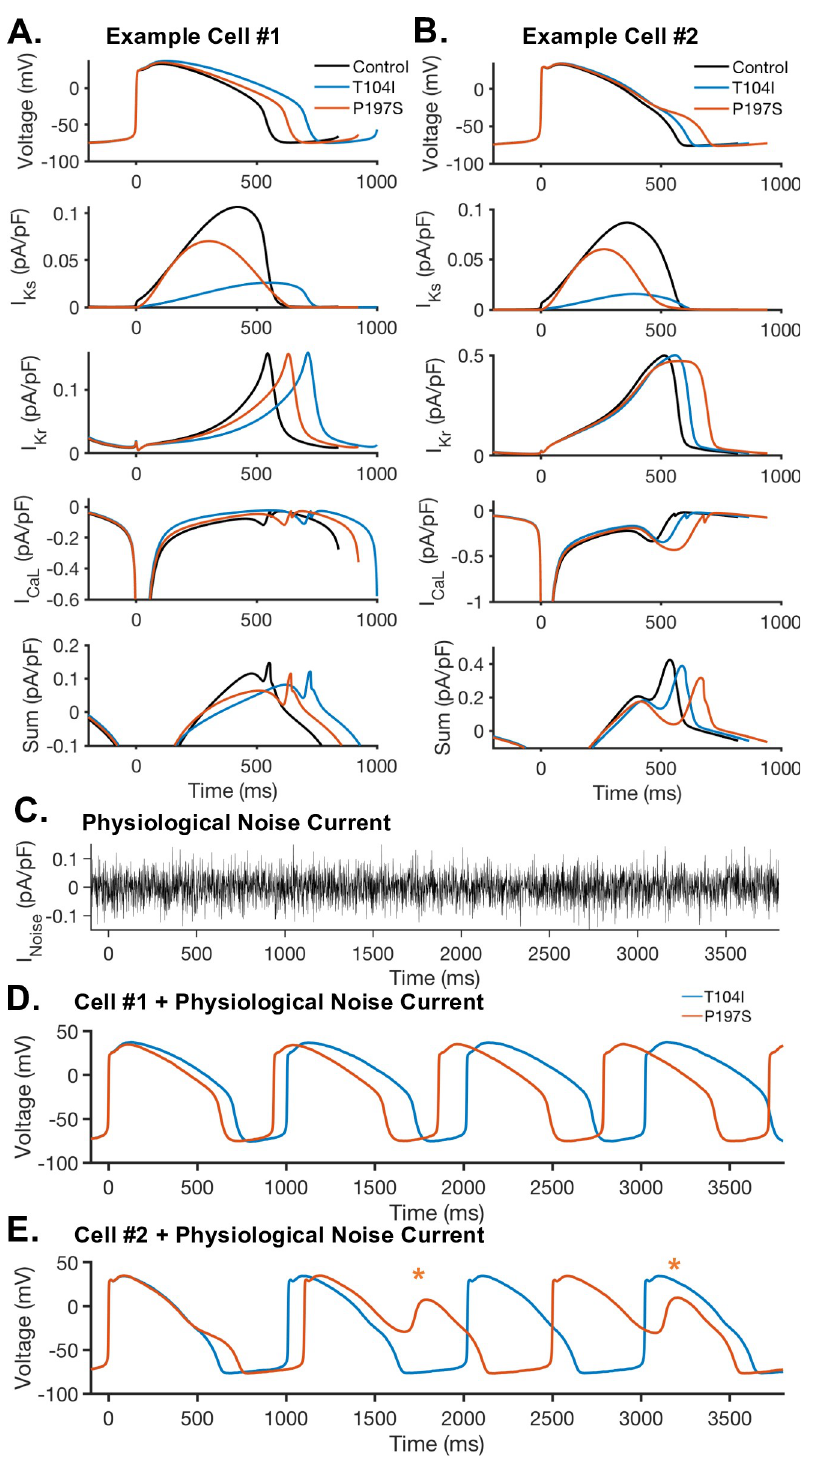
Fig 5. Comparison of ionic currents and response to physiological noise current in T104I and P197S mutant models. Sample action potentials from simulated cells with differential response to the T104I and P197S mutations are shown with their underlying currents. (A) Example cell #1 shows more AP prolongation in response to the T104I mutation. The underlying behavior of I Kr , I Ks , and I CaL is shown during the AP, as well as the sum of these three currents (I Kr + I Ks + I CaL ). (B) Example cell #2 shows more AP prolongation in response to the P197S mutation.